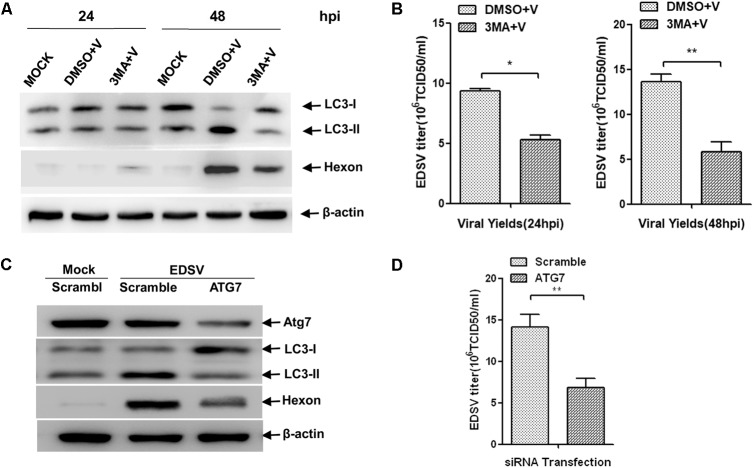
Inhibition of autophagy reduces EDSV replication in EDSV cells. (A) Western blot analysis of the effect of 3MA (5 mM) on the expression of both LC3 and hexon proteins in DEFs. Cells infected with DMSO (mock), cells infected with EDSV at an MOI of 1 (DMSO+V) and cells treated with 3MA for 4 h and then infected with EDSV an MOI of 1 (3MA+V) were harvested at 24 and 48 hpi. Cell samples were processed for western blot analysis, using antibodies against LC3, hexon, and β-actin, at 24 and 48 hpi. (C) Western blot analysis of the effect of ATG7 silencing on the expression of both LC3 and hexon proteins in DEFs. DEFs were transfected with either ATG7 siRNA (ATG7) or non-targeting siRNA (Scramble). Cell samples were processed for western blot analysis using antibodies against ATG7, LC3, hexon, and β-actin at 48 hpi. (B,D) Quantification of the yields of progeny virus in EDSV-infected DEFs were determined according to the TCID50/mL. The results are shown as the mean ± SEM (n = 3). ∗P < 0.05; ∗∗P < 0.01; ∗∗∗P < 0.001.